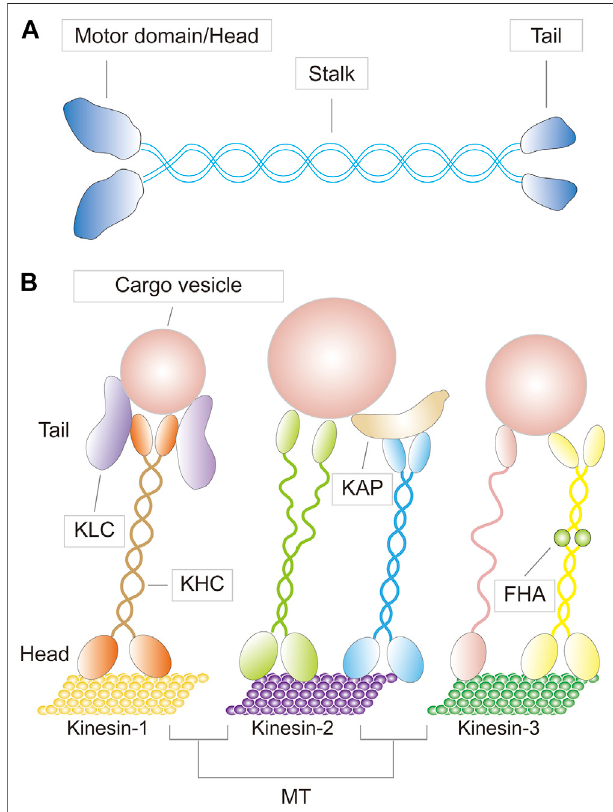
FIGURE 1 | (A) A schematic diagram depicting the basic structure of a kinesin motor (B) Three representative kinesins (kinesin-1,-2, and -3) bearing cargoes traveling on microtubule (MT) tracks, with their speci fi c molecular structures shown. KLC, kinesin light chain; KHC, kinesin heavy chain; KAP, kinesin associated protein; FHA, forkhead associated